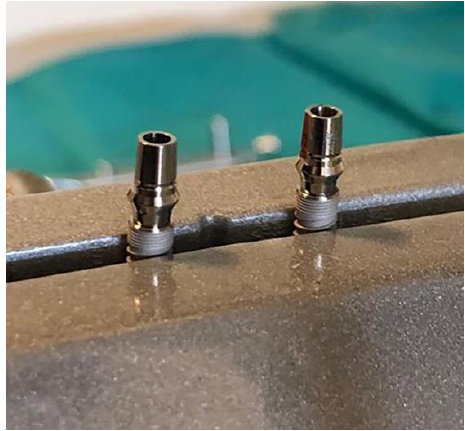
Figure 2. Implant–abutment compound in a sterile clamp.